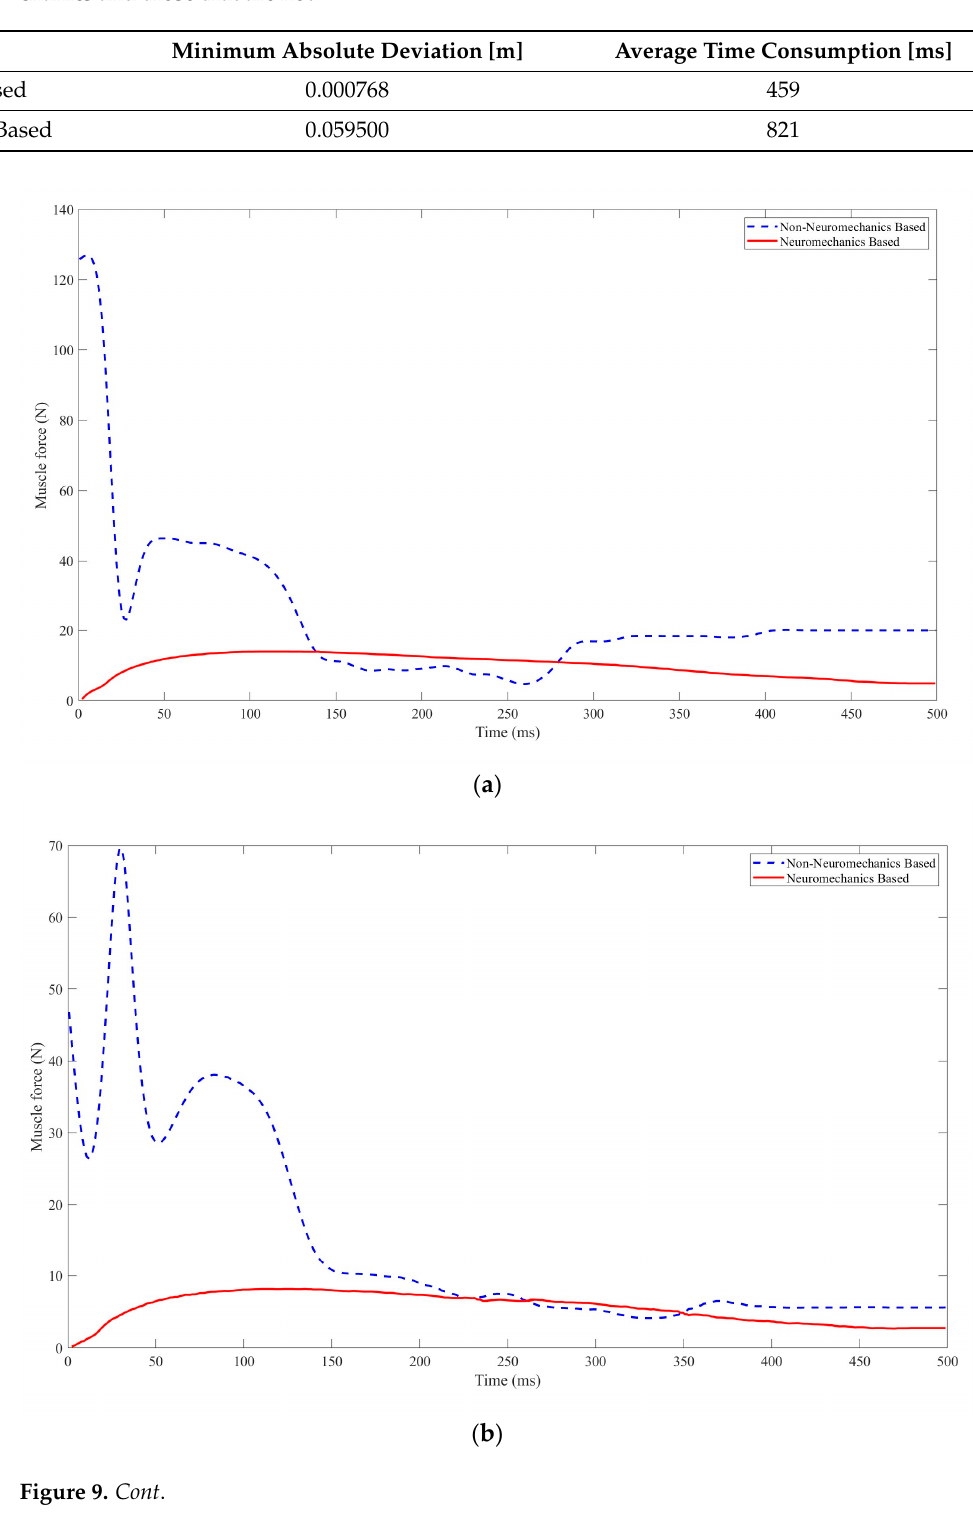
Table 7. Comparison II of the effectiveness of neural feedback controllers that are based on neurome- chanics and those that are not.